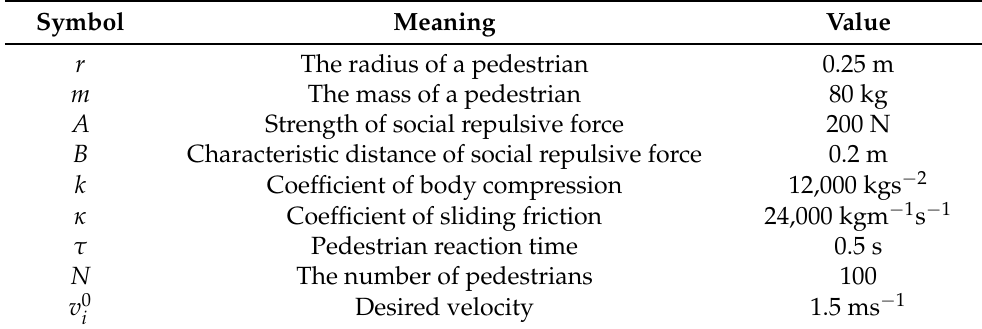
Table 1. Parameters in the